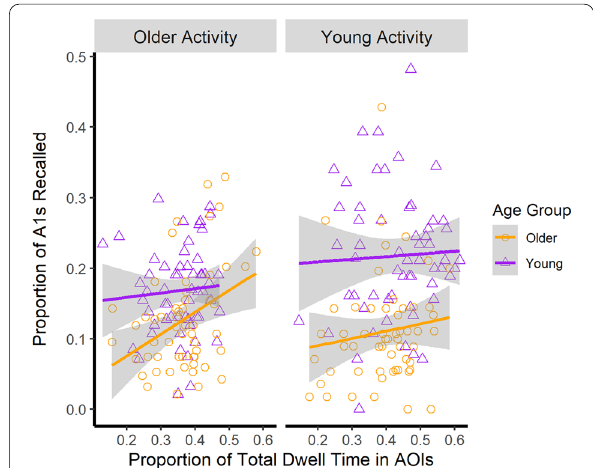
Fig. 7 Proportion of A1s recalled as a function of the proportion of time spent in the AOIs, activity, and age group. Raw values for each participant are represented by the points in the figure. Activity type is represented in the panels. Lines represent the predicted least square means generated from the estimated regression equation. The proportion of total dwell time in the areas of interest positively predicted event memory. Error ribbons correspond to 1 standard error around the line of best fit